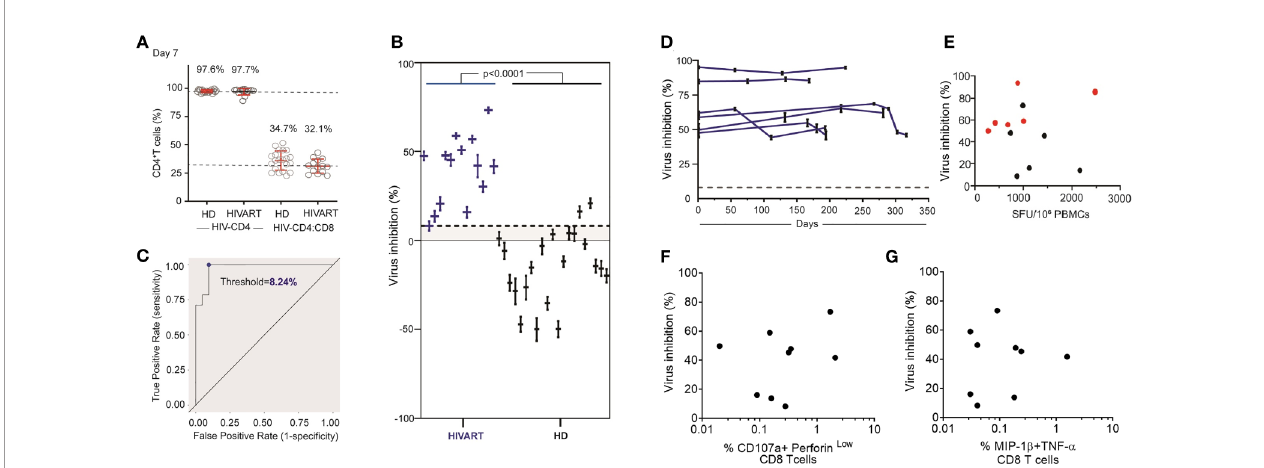
( Figure 3A , %CD4 T cells in total T cells: HD T cell=34.7%, HIVART=32.1%, n=35), suggesting a high and consistent purity of CD4 and CD8 T cell isolation. These ratios also indicate